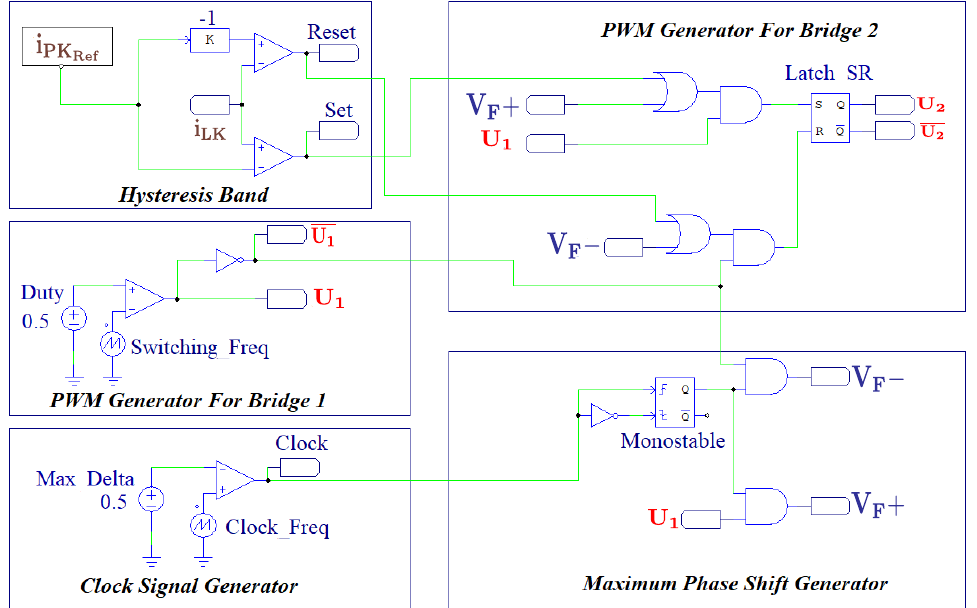
Figure 12. Implementation of the peak current